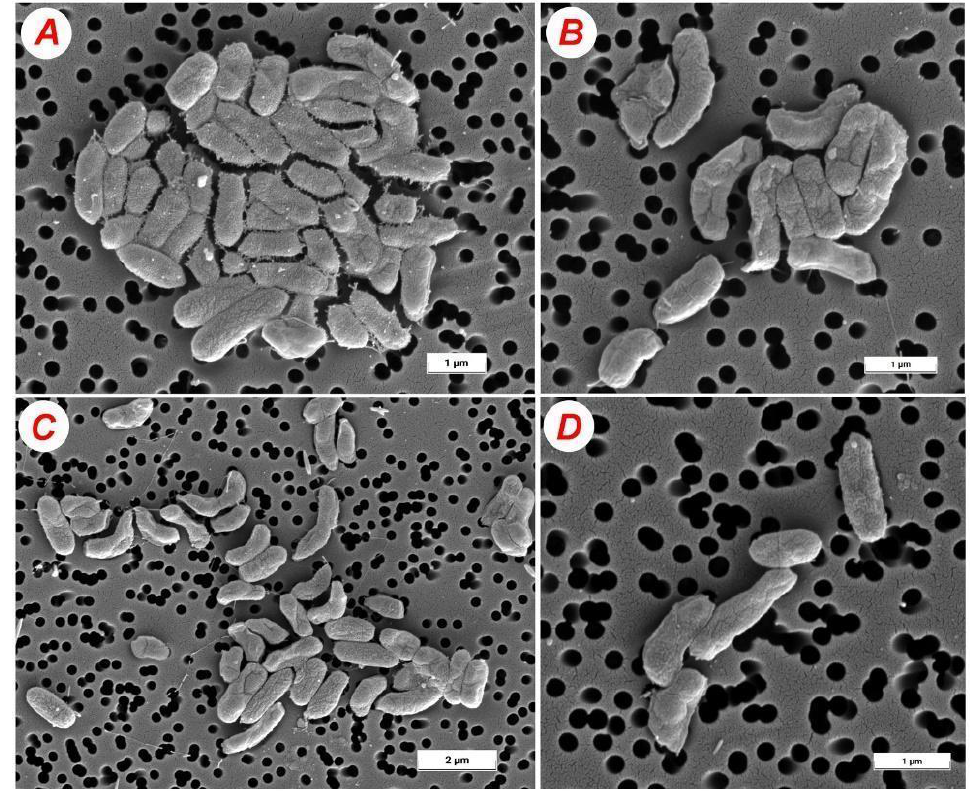
Figure 1. The morphology of Desulfovibrio cells from patients with IBD. Note. Strains from patient with Crohn’s disease: D. vulgaris M1.2 ( A ), ulcerative colitis: D. vulgaris M3.1 ( B ) and control (healthy): D. vulgaris Z8.2 ( C ) and D. vulgaris Z11.1. ( D ).